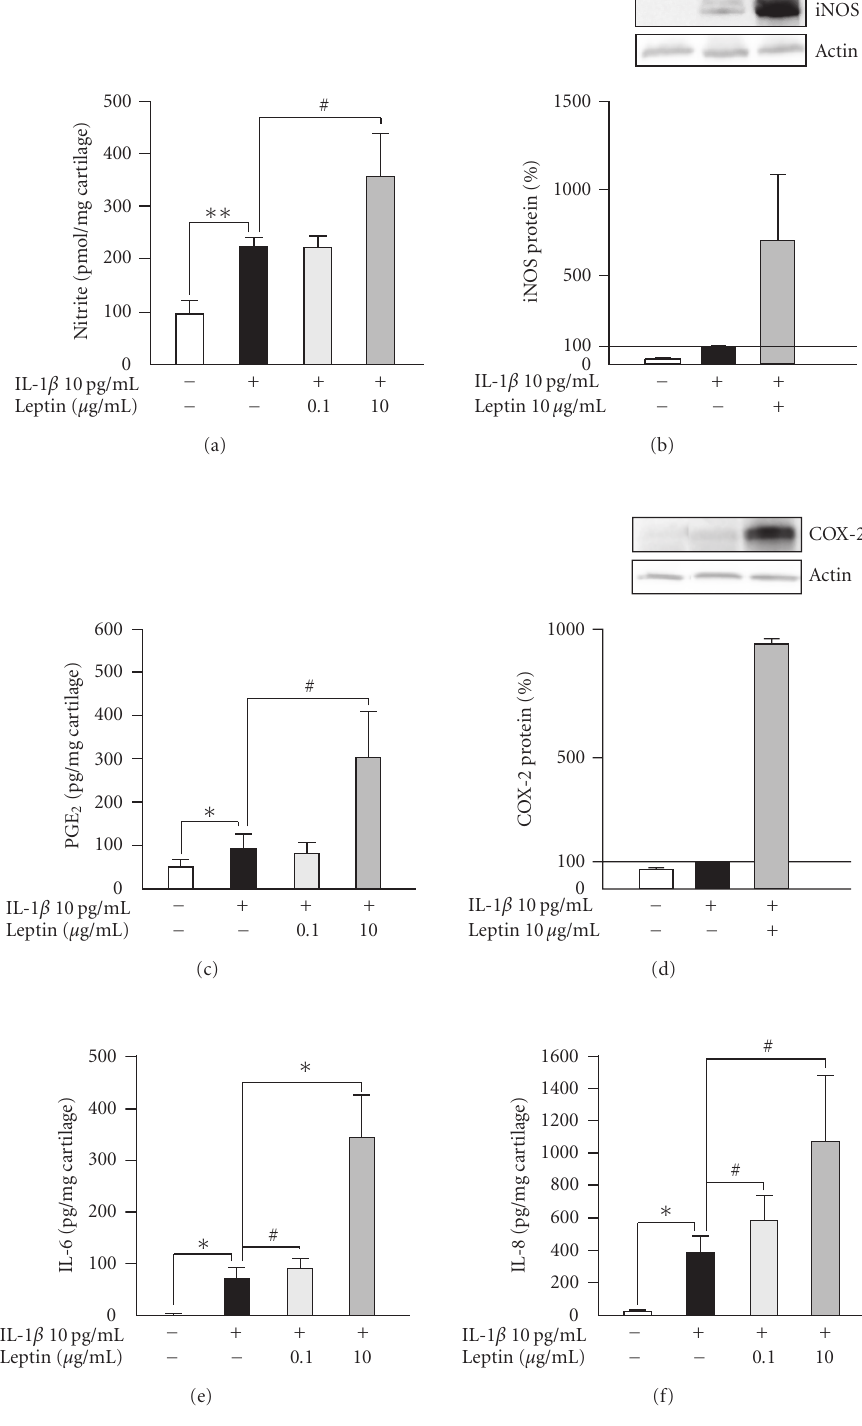
Figure 2: The e ff ect of leptin on NO production (a), iNOS protein expression (b), PGE 2 production (c), COX-2 protein expression (d), IL-6 production (e), and IL-8 production (f) in human OA cartilage in the presence of IL-1 β . Cartilage explants were incubated with IL- 1 β (10 pg/mL) alone or in combination with leptin (0.1 μ g/mL or 10 μ g/mL) for 48 hours. NO production (a) was measured as nitrite accumulation in the culture medium by Griess reaction. Expression of iNOS protein (b) and COX-2 protein (d) were measured by Western blot. PGE 2 production (c) in the culture medium was measured by RIA. Concentrations of IL-6 (e) and IL-8 (f) in the culture medium were measured by ELISA. Results are expressed as pmol/mg cartilage (a), as percentages in comparison with control sample ((b) and (d)) or pg/mg cartilage ((c), (e), and (f)). Values are mean ± SEM. Samples were collected from 6 patients ( n = 6) in (a) and (c), from 3 patients ( n = 3) in (b) and (d), and from 7 patients ( n = 7) in (e) and (f). #: P < . 2, ∗ : P < . 05, and ∗∗ : P < .